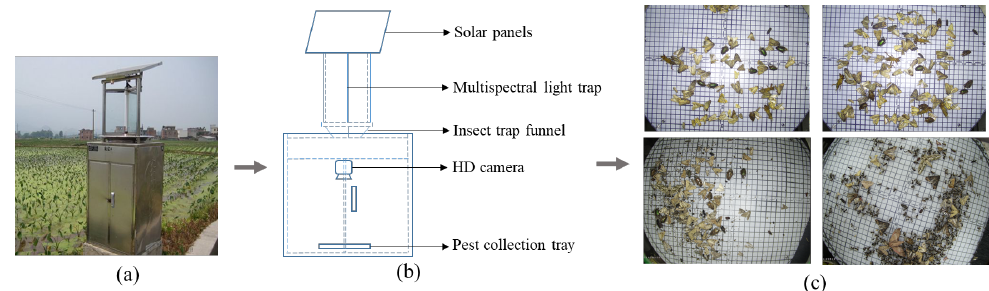
Figure 2. Pest image acquisition equipment. ( a ) Appearance of the device. ( b ) Inside structure. ( c ) Pest image